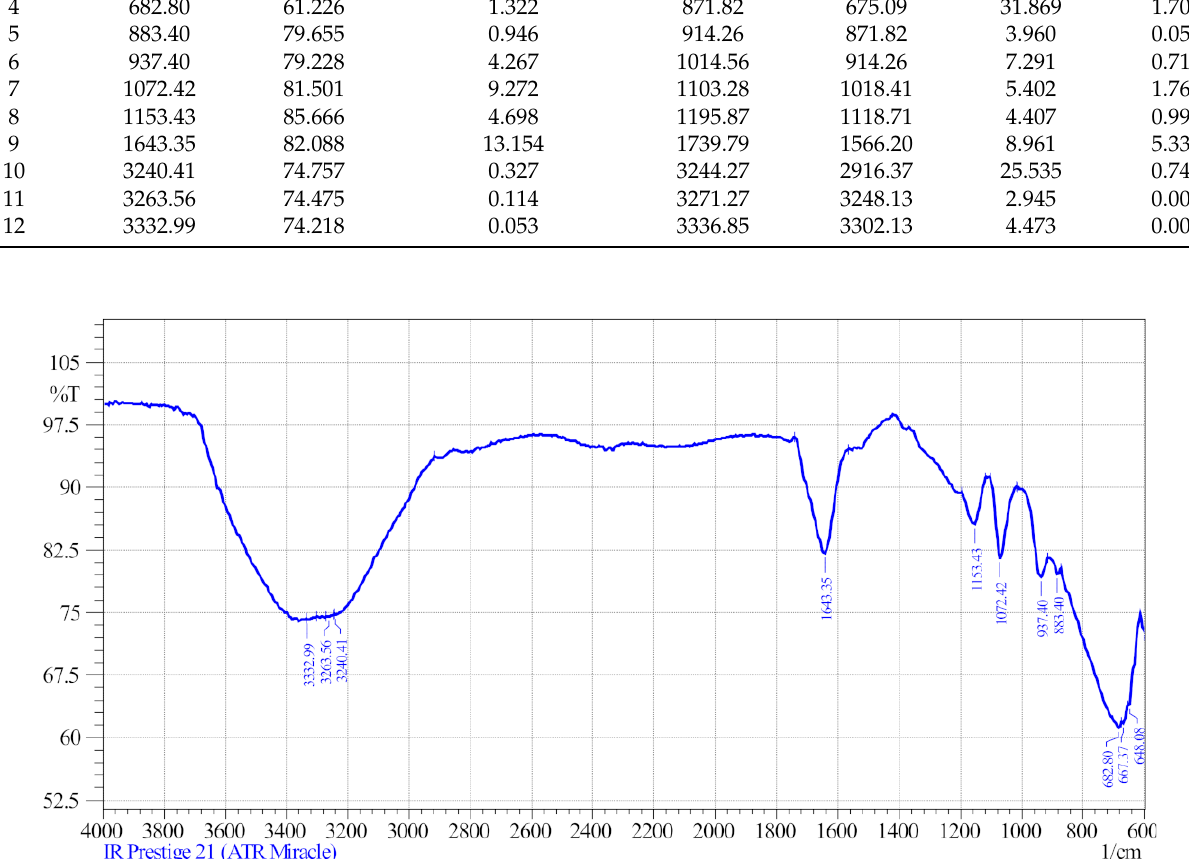
Figure 10. IR spectra of potassium